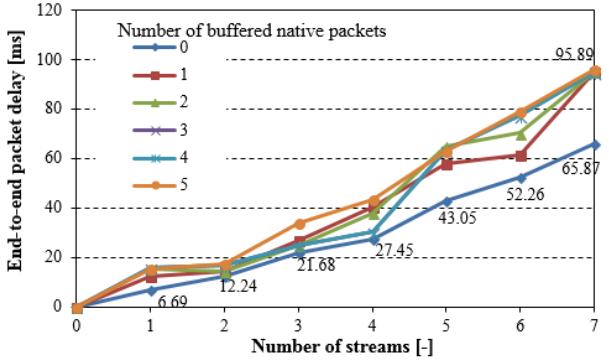
Figure 8. End-to-end packet delay (simple testing scenario).